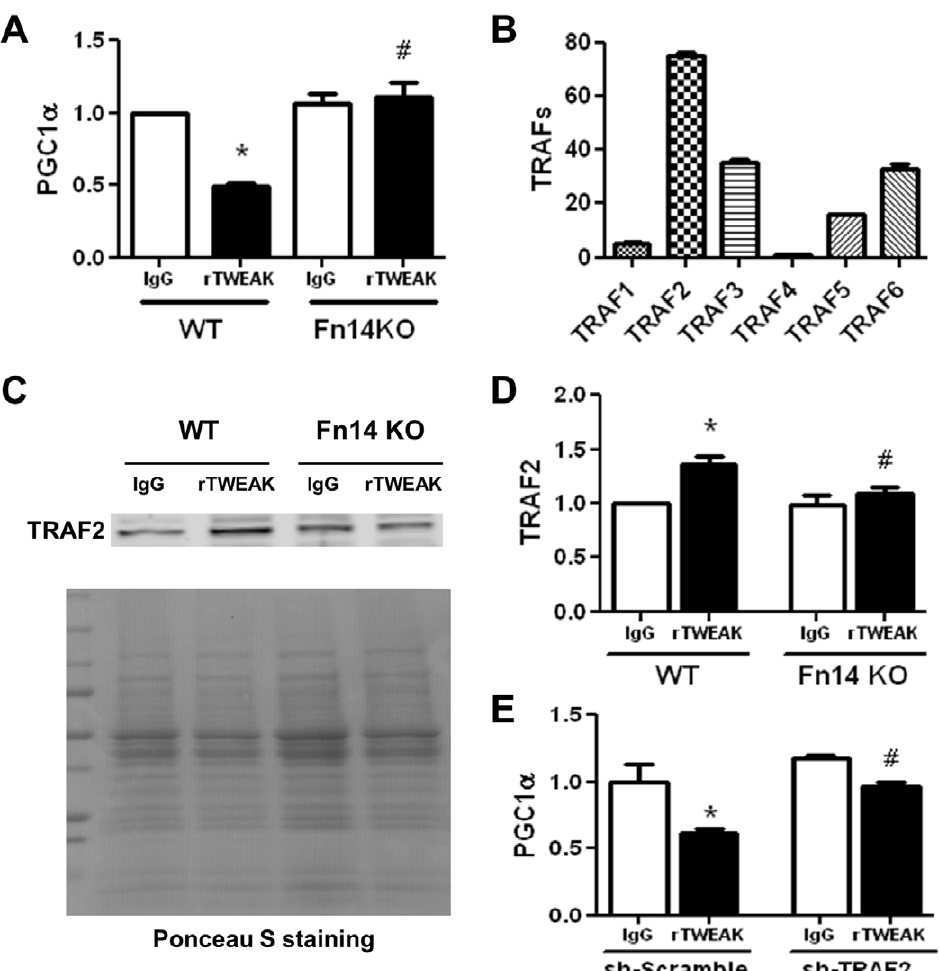
Figure 3. Fn14 is required for TWEAK-mediated down-regulation of PGC1 a expression and TRAF2 membrane translocation. Cardiomyocytes isolated from WT and Fn14 KO mice were treated with 100 ng/ml IgG or rTWEAK, and then harvested for determination of PGC1 a expression and TRAF2 membrane translocation. (A) Real time PCR analysis for PGCl a expression post IgG and rTWEAK treatment, normalized to b - actin and presented relative to the IgG treated WT group. (B) Real time PCR analysis for gene expression profiling of TRAF family proteins, expressed as the mRNA ratio of TRAF/ b -actin. (C) Immunoblot analysis for TRAF2 membrane translocation after IgG and rTWEAK treatment for 10 min. Lower panel shows Ponceau S staining of PVDF membranes that was used for evaluation of protein loading amount. (D) Bar-graph shows the relative levels of TRAF2 by densitomitric analysis with IgG treated WT group as 1-fold. * p , 0.05 vs. IgG treatment in WT group, # p , 0.05 vs. rTWEAK treatment in WT group. (E) Silencing of TRAF2 using shRNA (sh-TRAF2) prevents TWEAK-induced downregulation of PGC1 a . * p , 0.05 vs. IgG in sh-Scramble group, and # p , 0.05 vs. rTWEAK in sh-Scramble group.